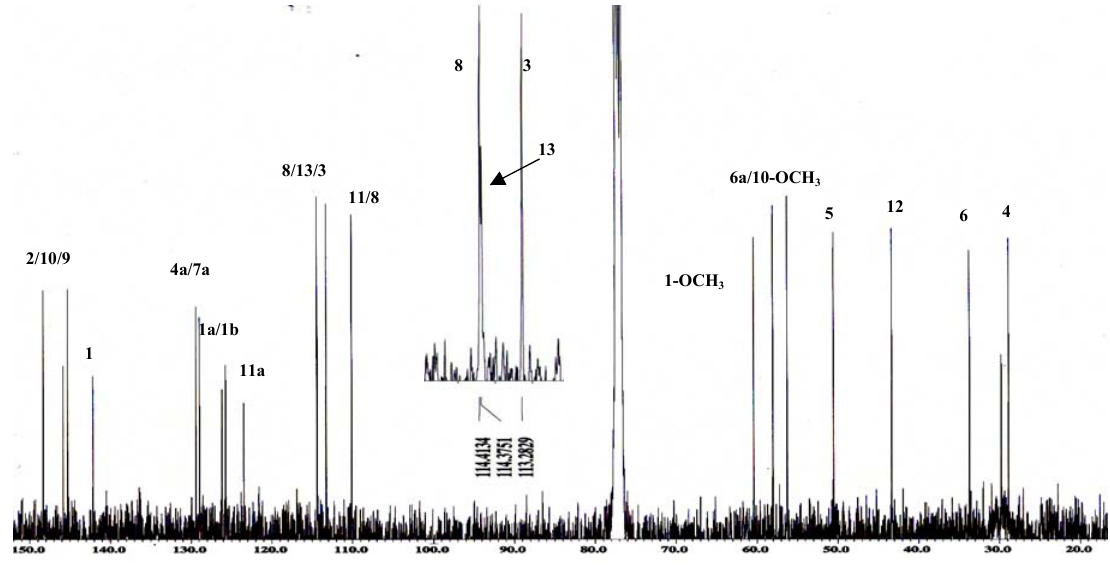
Figure 4. 13 C-NMR spectrum of alkaloid 1